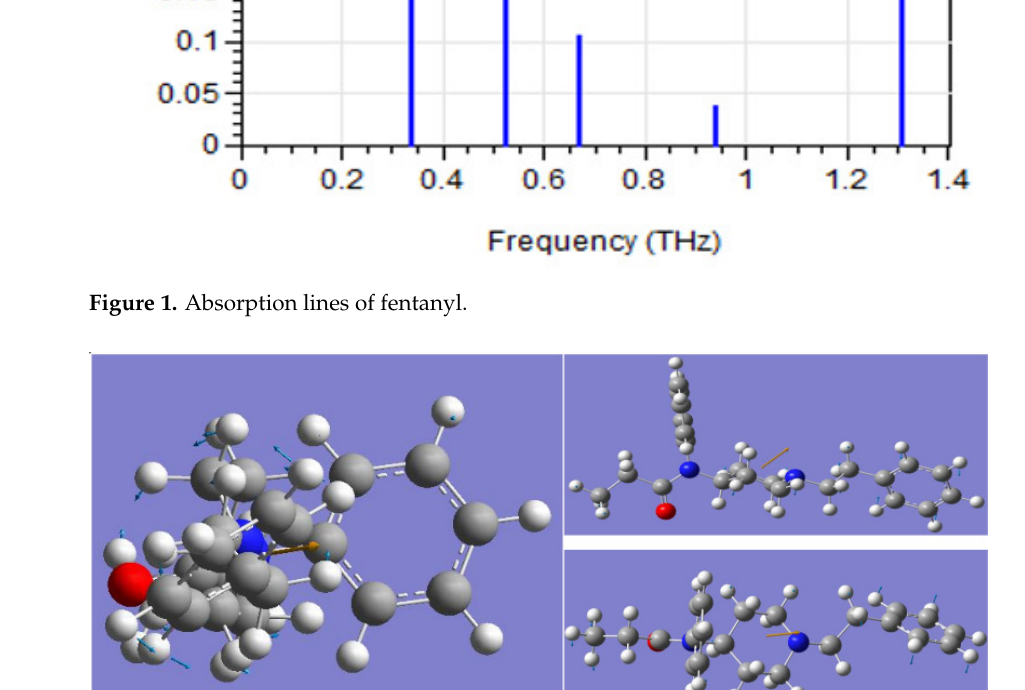
Figure 2. Fentanyl, the lowest 0.337 THz vibration mode. Three views of atomic motions (blue arrows) and dipole moment derivative (brown arrow). Color legends: Grey—carbon, blue—nitrogen, red—oxygen, and